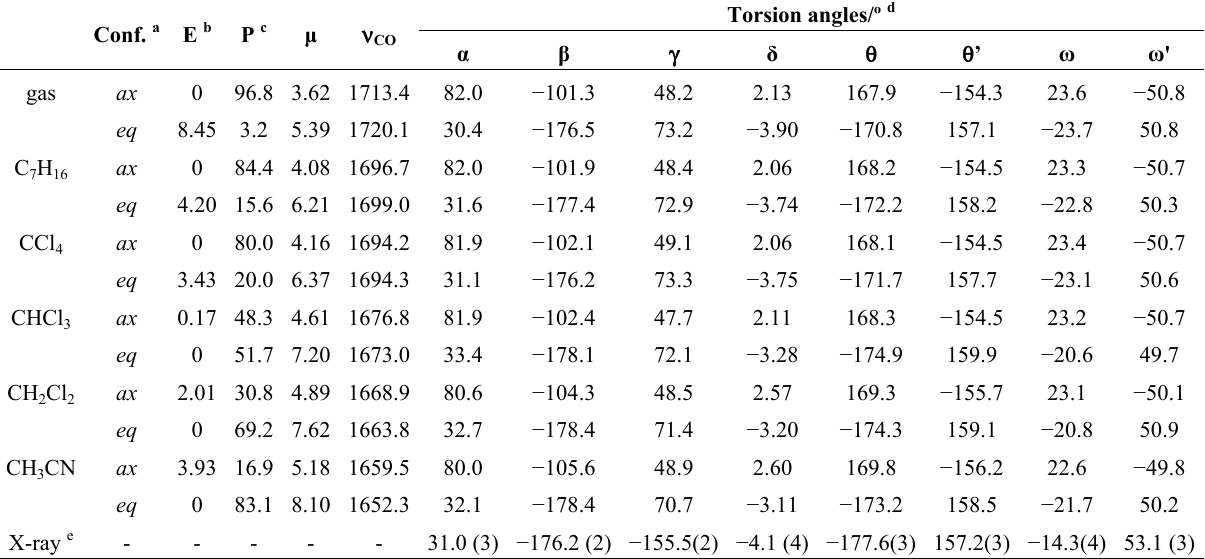
Table 2. Relative energies (E, kJ mol − 1 ), dipole moments ( μ , D), carbonyl frequencies ( ν , cm − 1 ), and selected torsion angles (deg) calculated for the minimum energy conformations of 3-phenylthio-1-methyl-2-piperidone 4 in gas phase and in solvents with the PCM method at the B3LYP/6-31+G(d,p) level, and the X-ray geometric data of 2